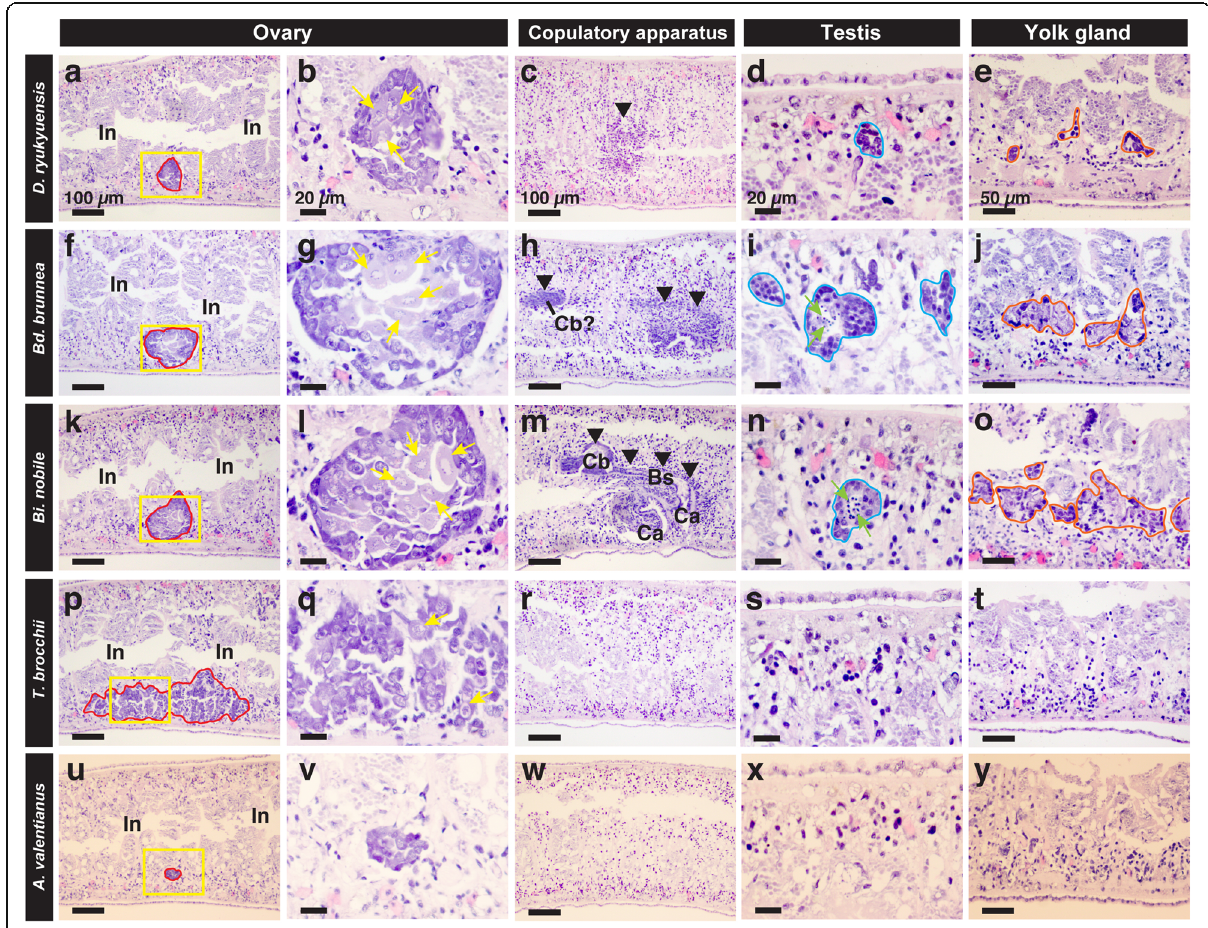
Fig. 5 Histological analysis of test worms obtained by the administration of Fr. M0 or M10. Embedded test worms fed with either Fr. M0 or M10 were sagittally sectioned and stained with hematoxylin and eosin (HE). The dorsal sides are at the top. a – e Fr. M10 from D. ryukyuensis , ( f – j ) Fr. M10 from Bd. brunnea , ( k – o ) Fr. M0 from Bi. nobile, ( p – t ) Fr. M10 from T. brocchii and ( u – y ) Fr. M0 from A. valentianus . ( a , f , k , p , and u ) Domains bound by the red line are the female germ cell masses (ovaries). In, intestine. Scale bar, 100 μ m. ( b , g , l , q , and v ) High magnification of the areas squared by the yellow line in ( a , f , k , p , and u ), respectively. Scale bar, 20 μ m. ( c , h , m , r , and w ) The region indicated by the arrowheads is a developing copulatory apparatus. Ca, common antrum; Cb, copulatory bursa; Bs, bursa stalk. Scale bar, 100 μ m. ( d , i , n , s , and x) Domains bounded by the blue line are the male germ cell masses (testes). The cell indicated by the green arrow is a spermatid. Scale bar, 20 μ m. ( e , j , o , t , and y ) Domains bounded by the orange-colored line are yolk glands. Scale bar, 50 μ m